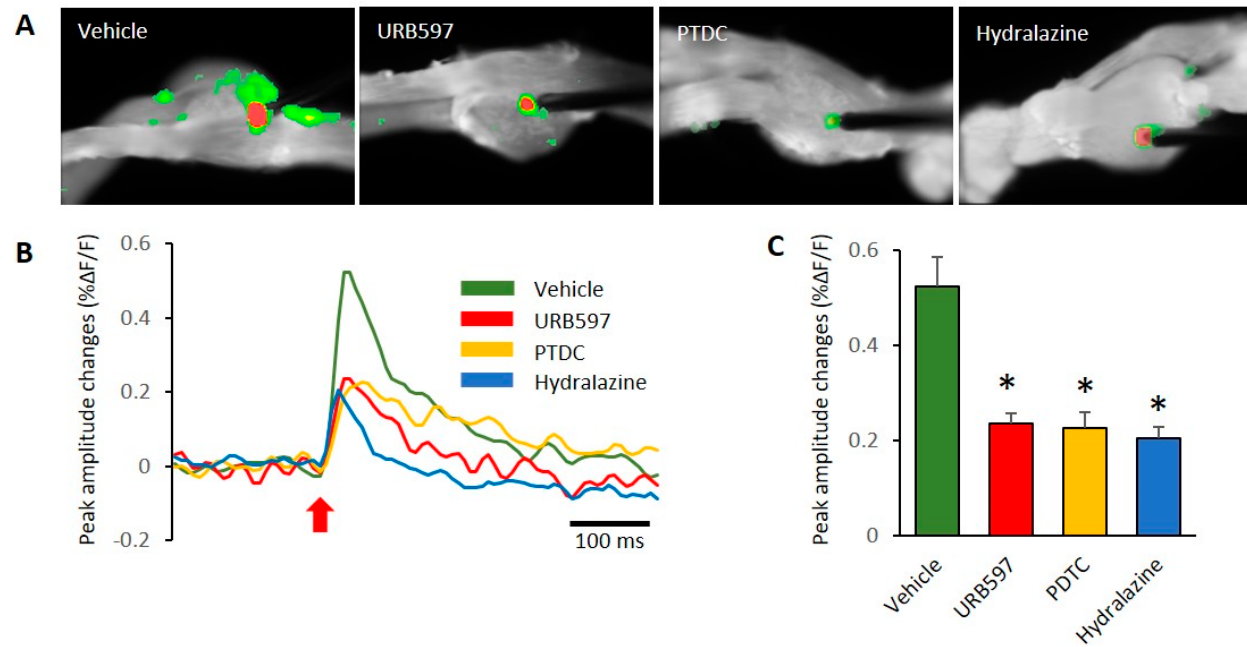
Figure 3. Comparison of DRG responses with electric stimulation in each group. ( A ) Comparison of VSD signals in the vehicle, URB597, PTDC, and hydralazine injection groups. ( B ) The typical time course of optical signals from DRG neurons. Red arrow represents the stimulus onset. Fluorescence changes: upward deflections of the signal indicate depolarization after electrical stimulation. ( C ) The reduced signals were observed in DRGs of drug-treated rats. n = 5 rats/group; one-way ANOVA followed by Tukey post hoc test was used for statistical analysis; data represent mean ± SEM; * p < 0.05.